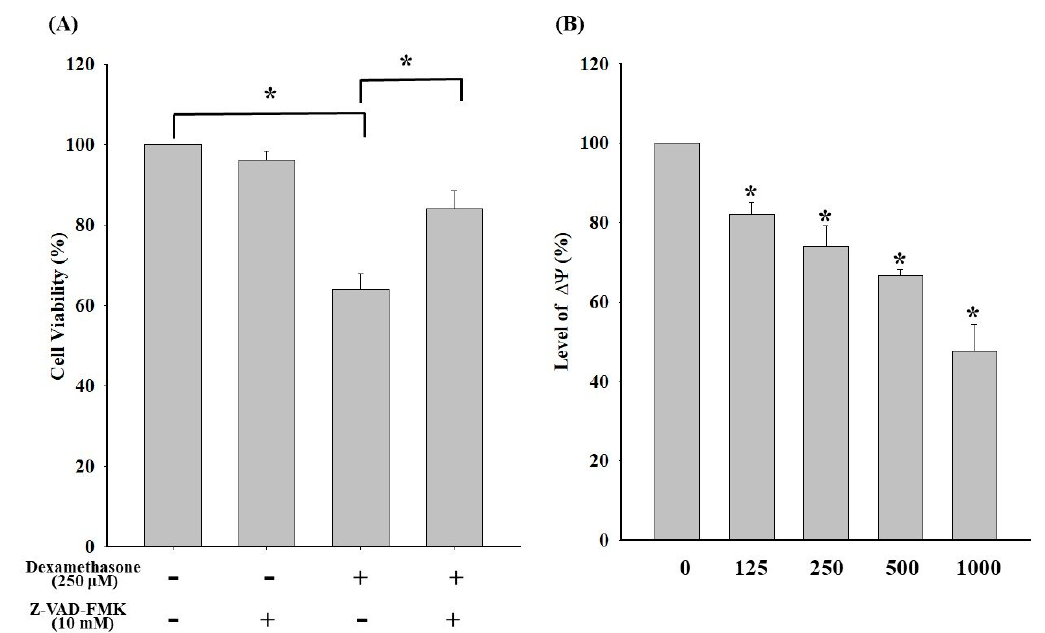
Figure 2. ( A ) E ff ect of the pan-caspase inhibitor Z-VAD-FMK on apoptosis in dexamethasone-treaded C2C12 myotube cells. Before dexamethasone treatment, the cells were pretreated with or without 10 µ M Z-VAD-FMK for 24 h. ( B ) E ff ects of dexamethasone on ∆Ψ m in C2C12 myotube cells. Cells were incubated with 0, 125, 250, 500, and 1000 µ M dexamethasone for 24 h. Values represent the mean ± SE (n = 8). Significant di ff erences were determined using Dunnett’s test (* p < 0.05, compared with the untreated group).